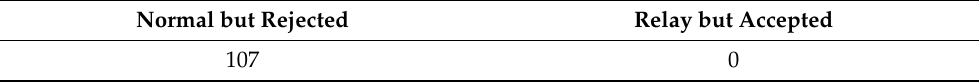
Table 3. Result of distinguishing between normal and relayed signals on testing